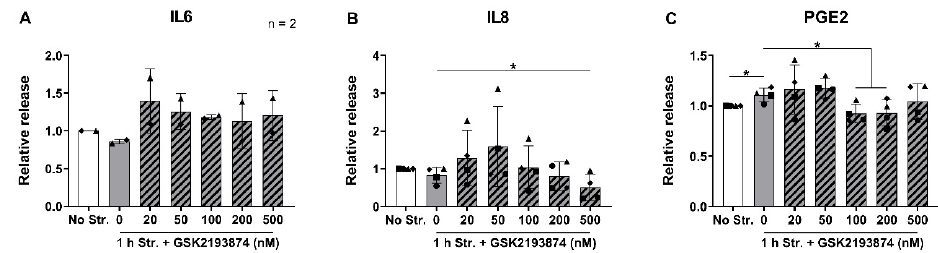
Figure 3. Relative release of ( A ) IL6; ( B ) IL8; and ( C ) PGE2 24 h after no (white bar) or 1 h (grey bars) of cyclic stretching at 20% strain and 1 Hz in the absence or presence (hatched bars) of 20–500 nM of the TRPV4 antagonist GSK2193874. n = 4 donors ( n = 2 for IL6); mean ± SD; * p < 0.05, ** p < 0.01, *** p <